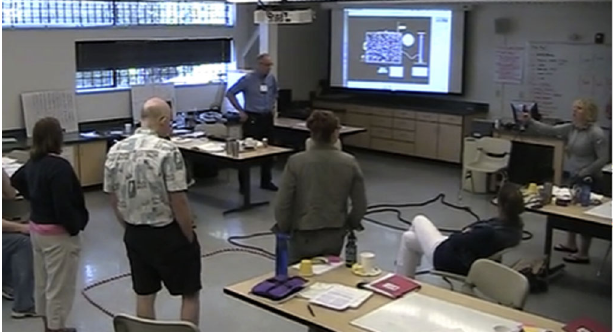
VIDEO 2. Participants prepare to enact Energy Theater for adiabatic compression of an ideal gas. In this episode, one participant points out an inconsistency between the collisions- generate-heat idea and her own model for